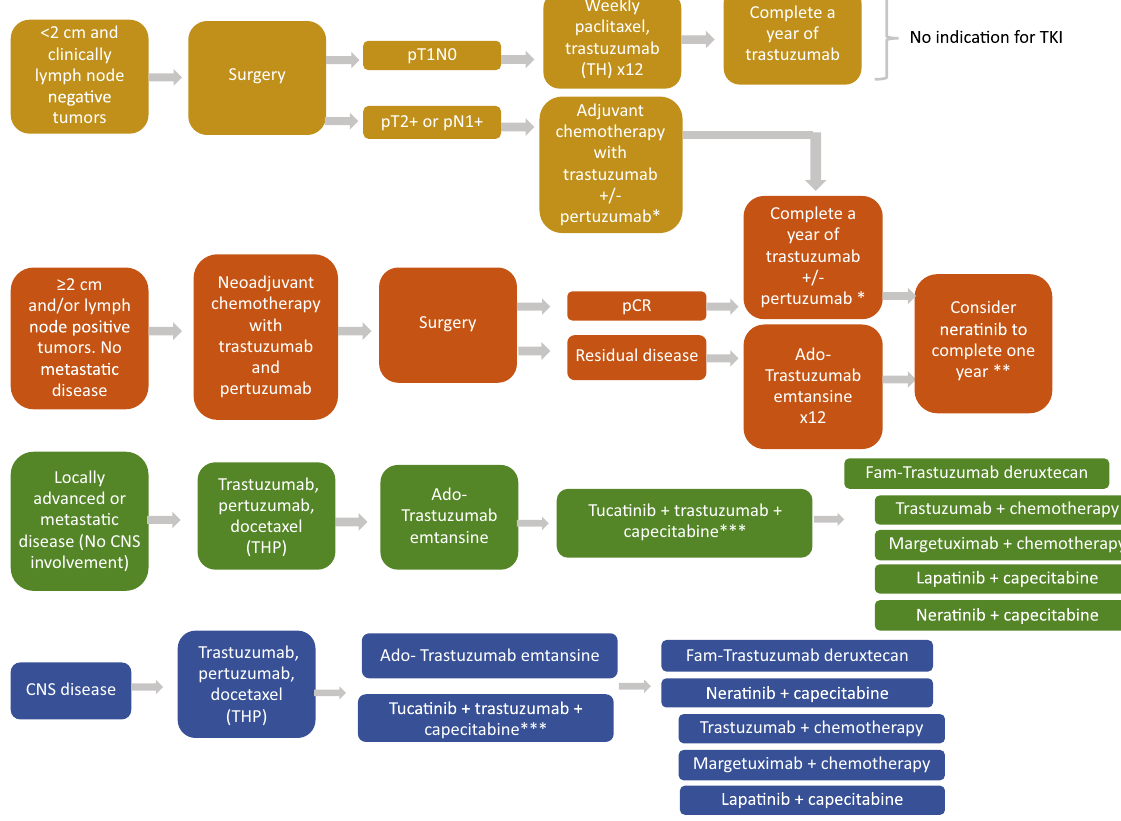
Fig. 3 Proposed treatment algorithm for HER2 + Breast Cancer. This is a suggested treatment algorithm for early stage and advanced human epidermal growth factor 2 positive BC, based on the current United States Food and Drug Administration approvals. Radiation therapy and endocrine therapy should be incorporated when appropriate. There are multiple options for metastatic disease beyond second line, tucatinib can be considered in the third line setting based on the results of the phase 3 HER2CLIMB study. Other agents can be considered as fourth line or beyond, based on prior therapies, toxicity pro fi le and comorbidities. *Subgroup analysis of APHINITY showed that patients with node positive disease have a greater bene fi t from adjuvant dual HER2 blockade. **Bene fi t seen in patients with hormone receptor positive and HER2 positive disease. There are no data about the use of neratinib after treatment with pertuzumab and/or ado-trastuzumab emtansine. ***Tucatinib is FDA approved in the second line setting after treatment with trastuzumab, pertuzumab and ado-trastuzumab emtansine. Can be considered for patients with CNS involvement.